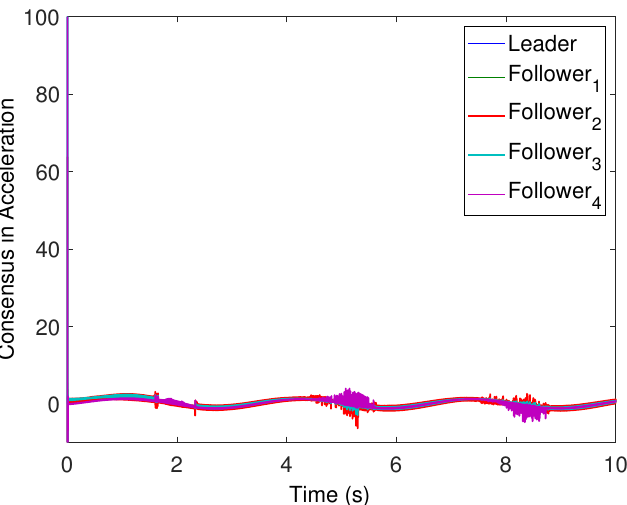
Figure 4. Acceleration consensus of the four followers with leader acceleration